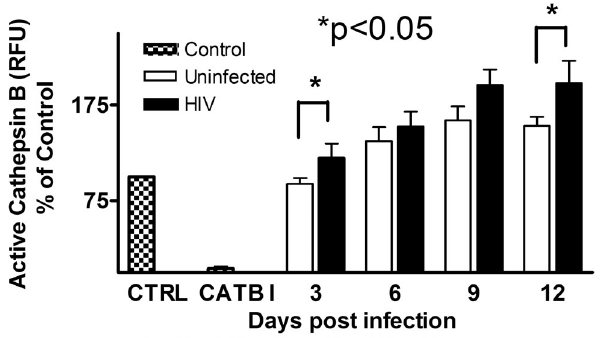
Figure 3. Secreted cathepsin B is more active in HIV-infected macrophages than in uninfected controls. Protein activity was measured by adding a synthetic peptide specific for cathepsin B conjugated to a red fluorogenic compound (RR 2 -AFC) and read in a fluorometer at 400 nm excitation and 505 nm emission filters. Culture fluids from HIV-infected macrophages showed a significant increase in the activity of secreted cathepsin B at 3 and 12 days post infection (*p # 0.05). Results for cathepsin B activity are expressed as percentages of control (media only). Increased cathepsin B activity over the days after HIV infection (mean estimate increase/day 9.25 (SE 2.61), p=0.002). The specificity of the assay is shown by the abrogation of any active cathepsin B after the addition of an inhibitor.